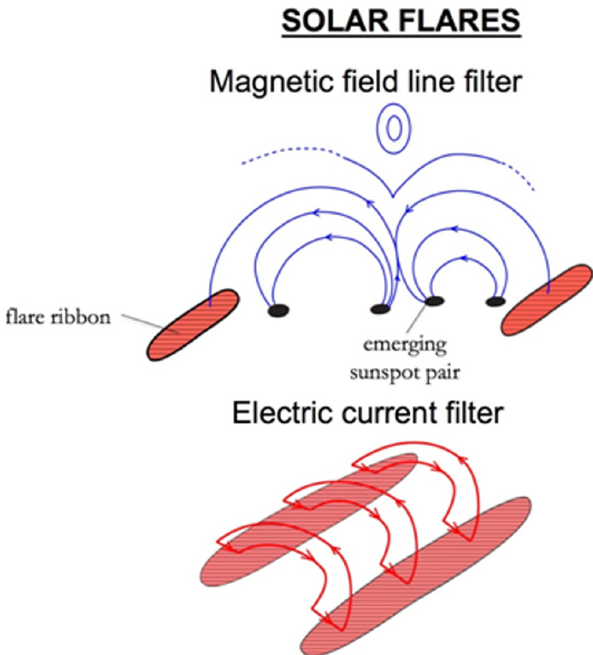
Fig. 18. The two views (magnetic field lines or electric currents) of a solar